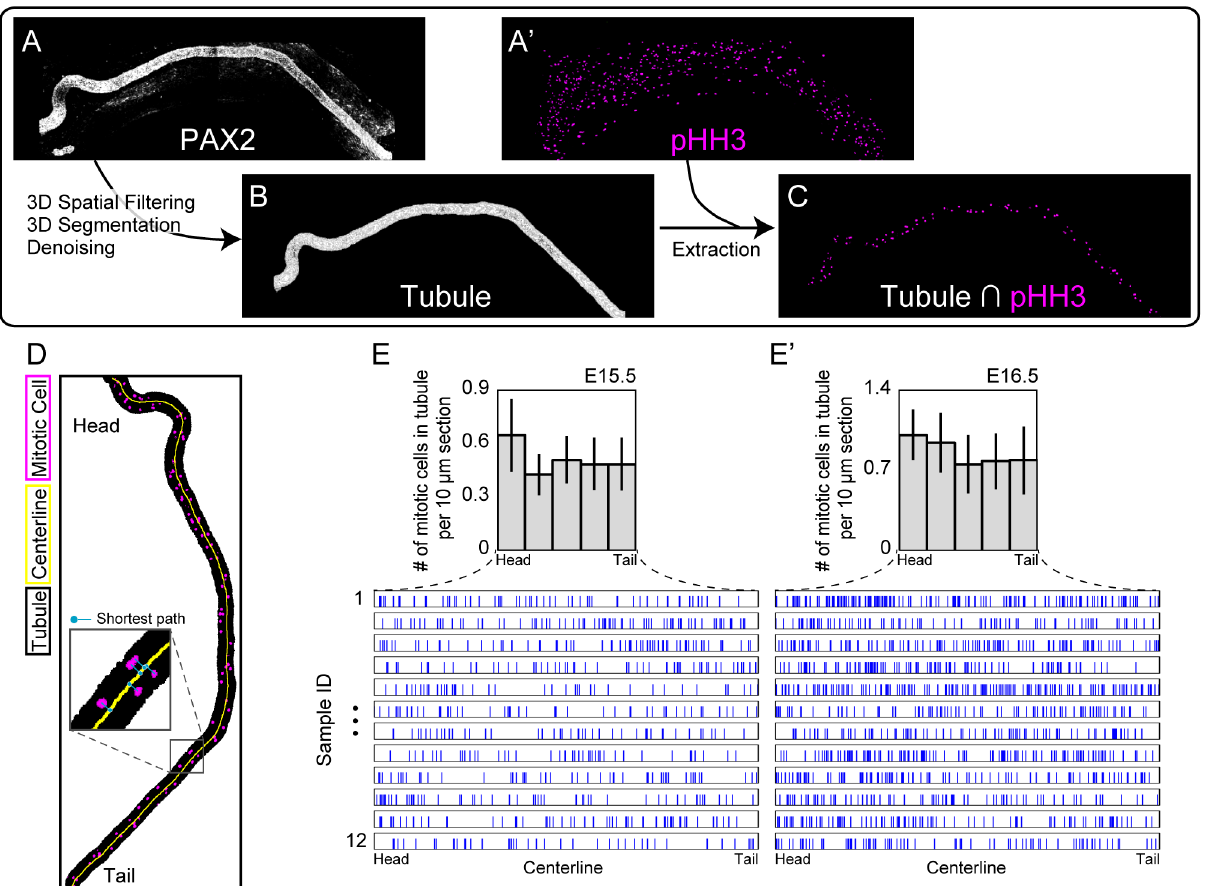
Fig 4. Whole-tissue quantification of the spatial distribution of mitotic cells along the epididymal tubule. (A – C) Overview of the procedure for digital image processing and 3D quantification used to acquire the spatial distribution of mitotic cells along the epididymal tubule. (A, A 0 ) A projected raw image of the immunofluorescence of Pax2, a marker for the epididymal tubule, as well as that for phospho histone H3, a mitosis marker, in the epididymis dissected at E16.5. (B) The Pax2-positive cells were extracted from the image (A) as an epididymal tubule via 3D image processing. (C) Mitotic cells located only in the tubule were obtained by masking (A 0 ) with (B) . (D) A superimposed image of the extracted epididymal tubule (black), extracted mitotic cells (magenta), and the centerline of the tubule was automatically obtained. The centerline was the result of image skeletonization (B) . A set of circles with lines colored in blue represent the shortest path to a position on the centerline from each mitotic cell. Note that an automatic count of mitotic cells along the tubule was performed in 3D, although the image was projected onto 2D for visualization. (E, E 0 ) Spatial distribution of mitotic cells in the epididymal tubule along the centerline of the tubule at E15.5 and E16.5. The histogram integrates the raw data in which the position of the mitotic cell is represented as a pulse. The value on the vertical histogram axis was normalized to that in a 10- μ m section. n = 12. The error bars represent s.d.